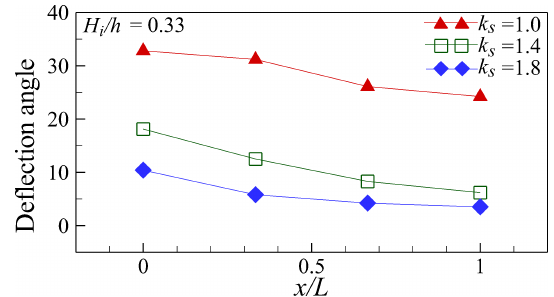
Figure 7. Comparison of the maximum deflection angle of moving cylinders with different spring